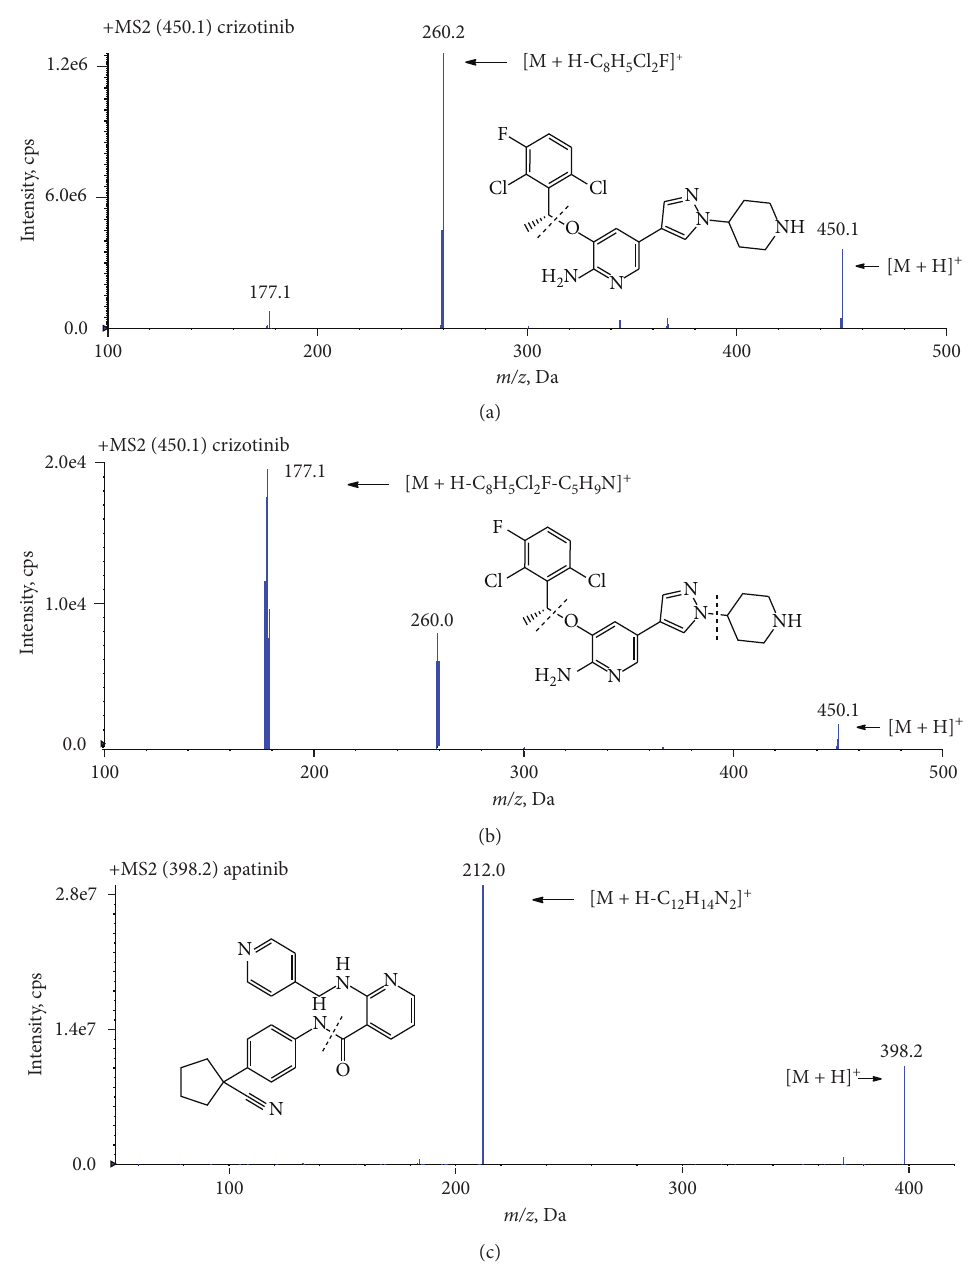
Figure 2: Product ion mass spectra of crizotinib (a, b) and apatinib (c) in positive mode and their proposed fragmentation